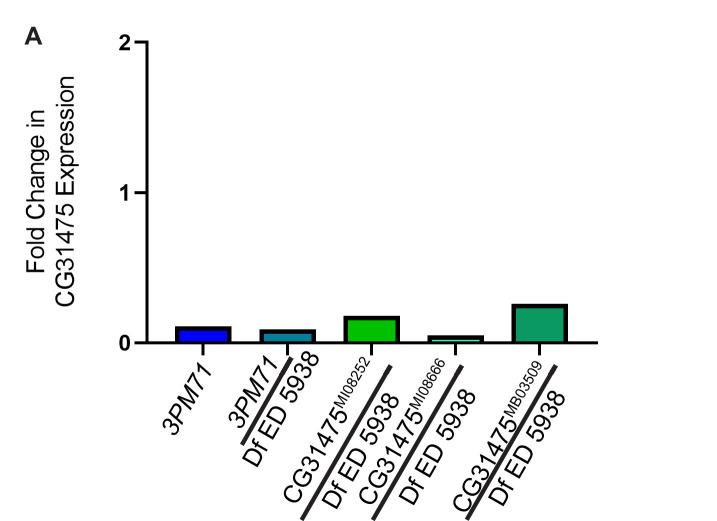
qPCR results.The fold change in CG31475 expression in comparison to WT. qPCR results were calculated by comparison of CG31475 transcript levels to Actin5C as an internal control using the 2(-▲▲CT) method. The fold change for 3PM71, 0.11, 3PM71/Df ED 5938 0.09, CG31475MI08282/Df ED 5938 0.18, CG31475MI08866/Df ED 5938 0.05 and CG31475MB03509/Df ED 5938 0.26, respectively.